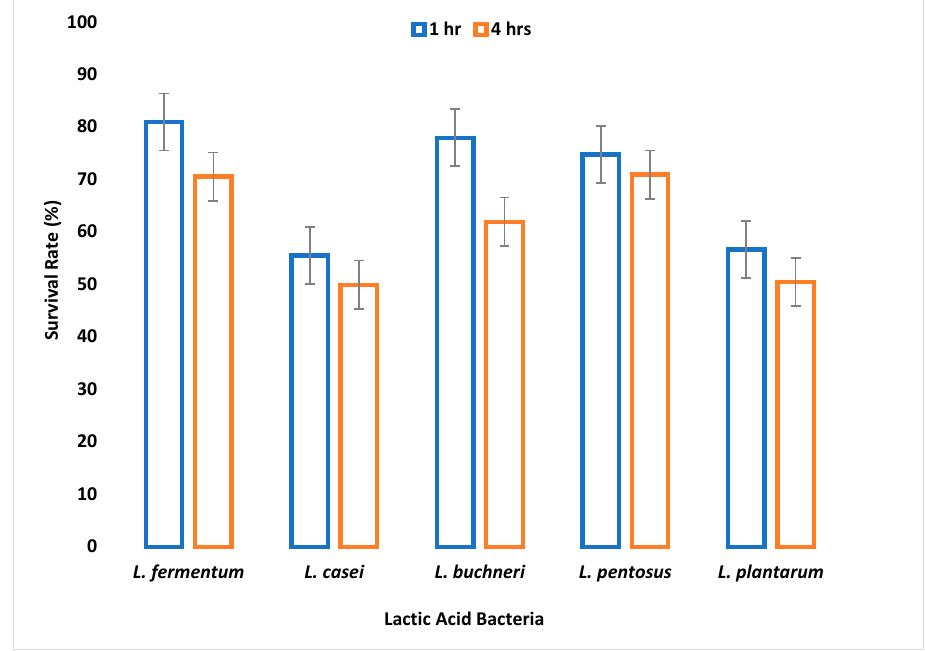
Figure 5. Survival of lactic acid bacteria isolates in 0.5% bile salt after 1 and 4 h, respectively. After 1 h, L. fermentum isolates survived well in 0.5% bile salt although at the end of 4 h in 0.5% bile salt, L. pentosus was the most adapted.